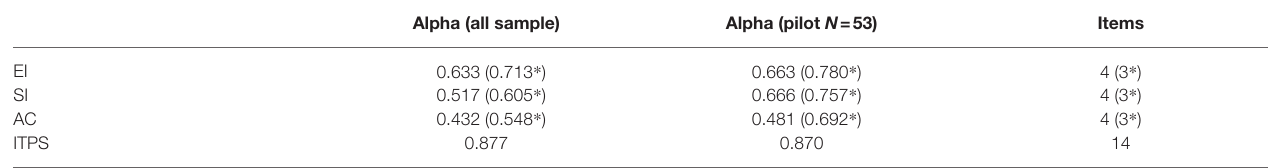
TABLE 1 | Reliability statistics for Perceptions of Inclusion Questionnaire (PIQ) subscales and Inclusive Teaching Practices Scale